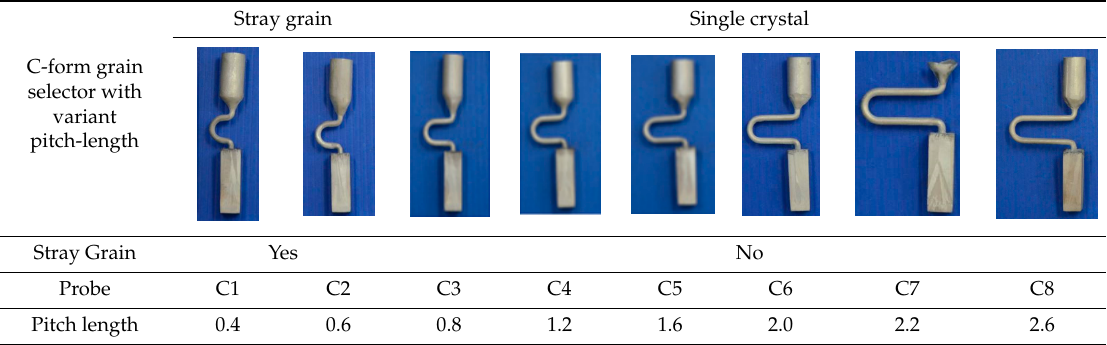
Table 3. Variation in the thickness of the grain selector portion: Group 1.